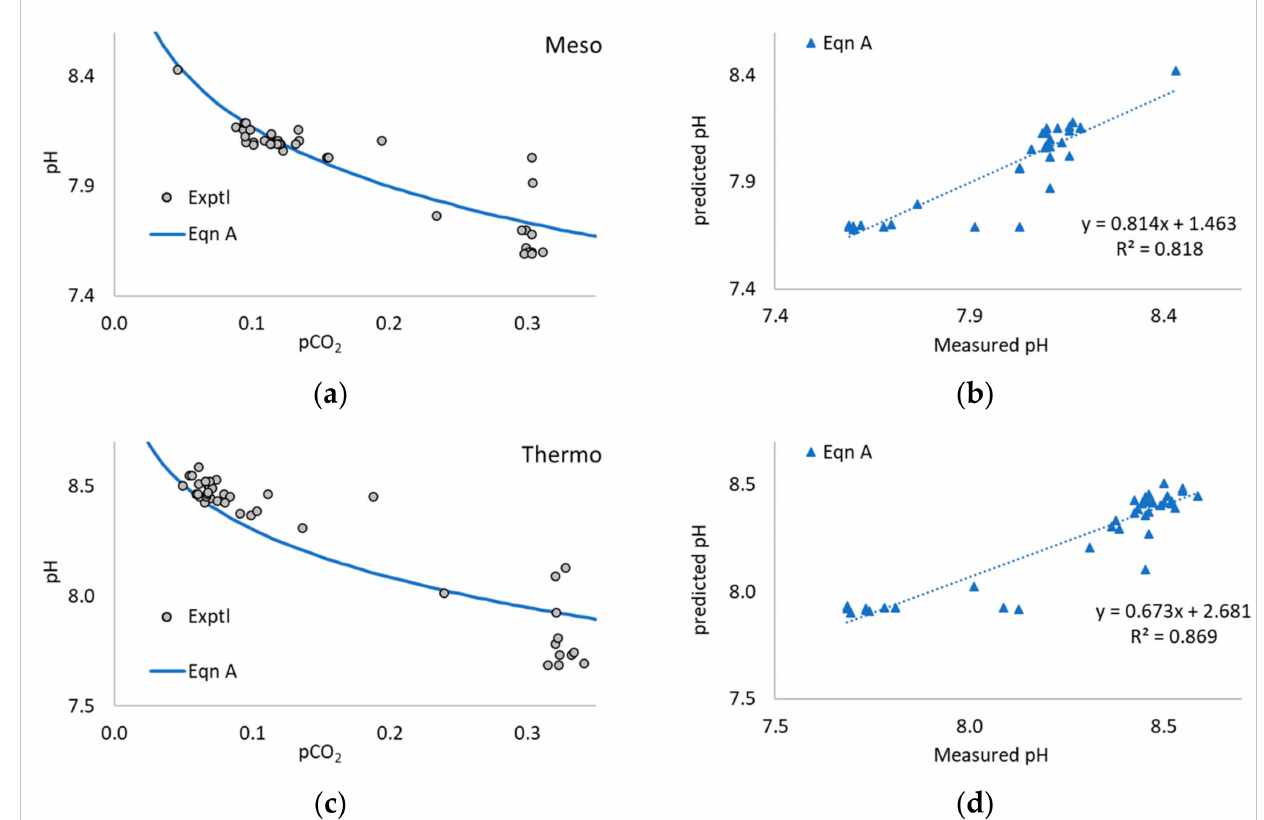
Figure A1. ( a ) Measured pCO 2 and measured and predicted pH values and ( b ) predicted pH values from Equations A and B for mesophilic CO 2 biomethanisation of industrial food waste for points with measured VFA and measured or interpolated TAN associated with Tao et al. [6]. See Figure 1c,d in the main text for results from Equation A for the full dataset, and Table S5 for operating conditions and average results for each phase.